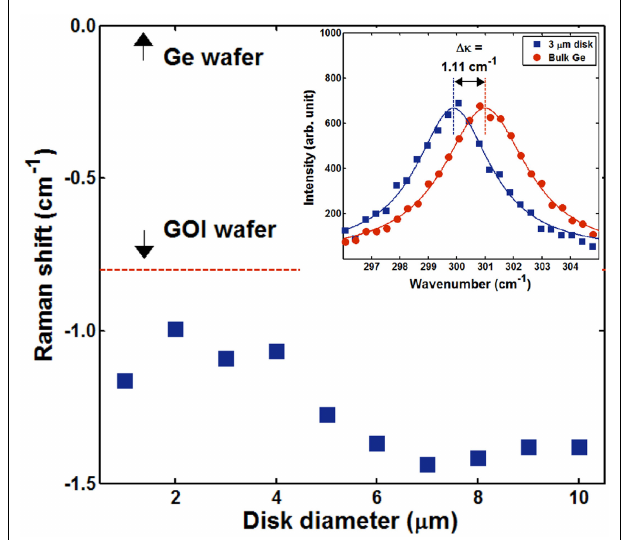
FIGURE 4 | Raman shift (from bulk Ge) in cm (cid:0) 1 for suspended Ge micro-disks with different diameters . Top inset shows the actual Raman spectra for bulk Ge and 3 µ m